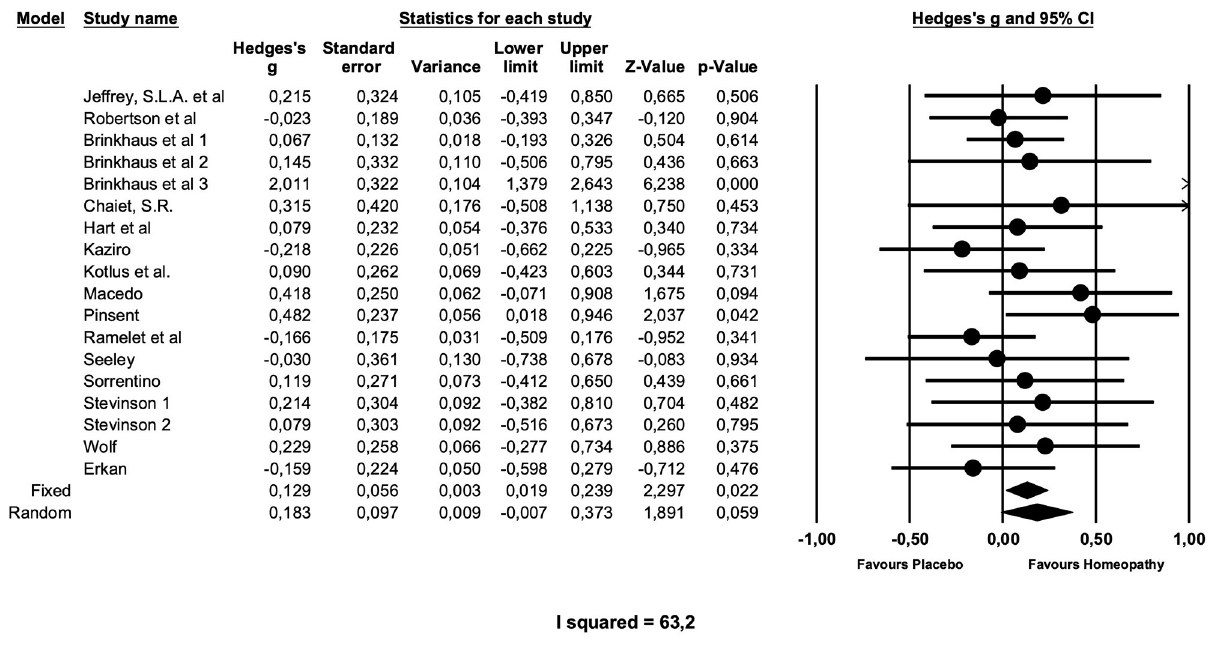
with undeclared potency had a high and significant effect size of g =